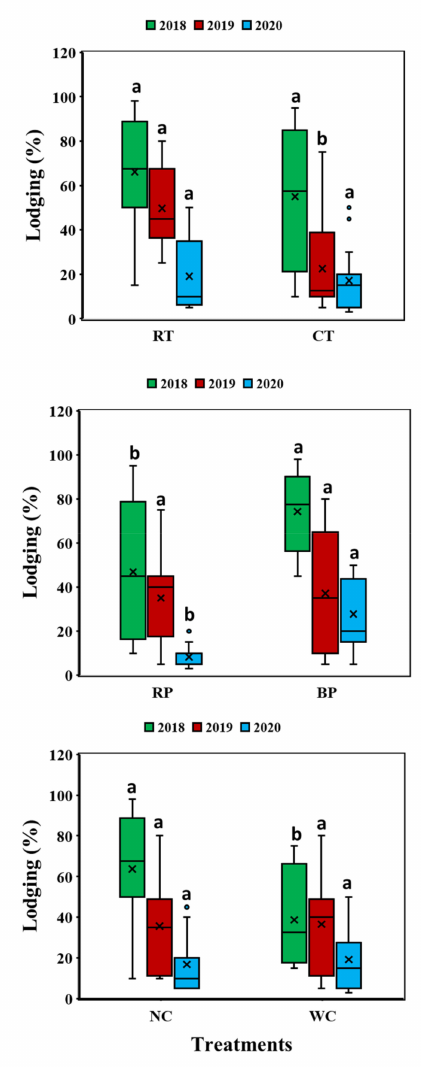
Figure 3. Effects of tillage, sowing, and soil compaction practices on teff lodging in 2018, 2019, and 2020. The top and bottom of each box represent the upper and lower quartiles, respectively; the horizontal line and the multiplication symbol ( × ) within each box represent the median and mean, respectively; whiskers represent variability outside the upper and lower quartiles. RT, reduced tillage; CT, conventional tillage; RP, row planting; BP, broadcast planting; WC, soil compacted; NC, soil not compacted. Within each year (similar color) across treatments, means with different letters are significantly different at p <